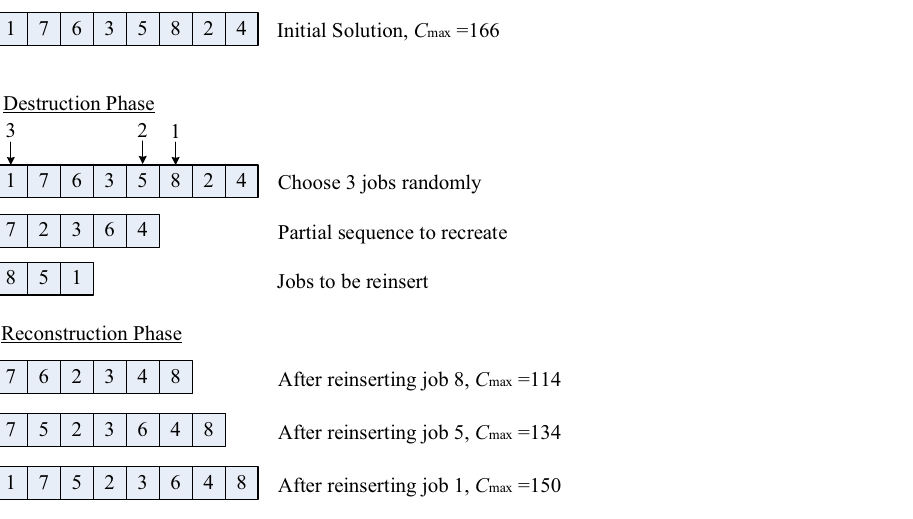
Figure 3. An example for one iteration of the LIG